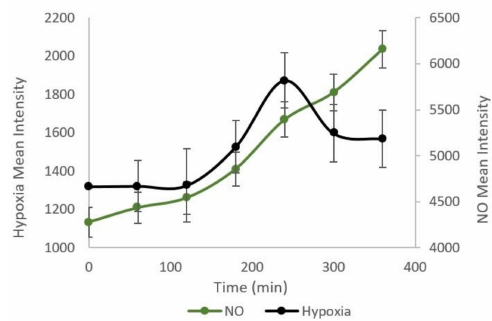
Figure 6. Simultaneous hypoxia and nitric oxide response from the cell culture. Simultaneous fluorescence signal from hypoxia and nitric oxide increased in the cells after 3 h of pumping O 2 -depleted H 2 O and SNP in meanders. The data were gathered from three independent experiments (n = 3) and error bars were measured from standard